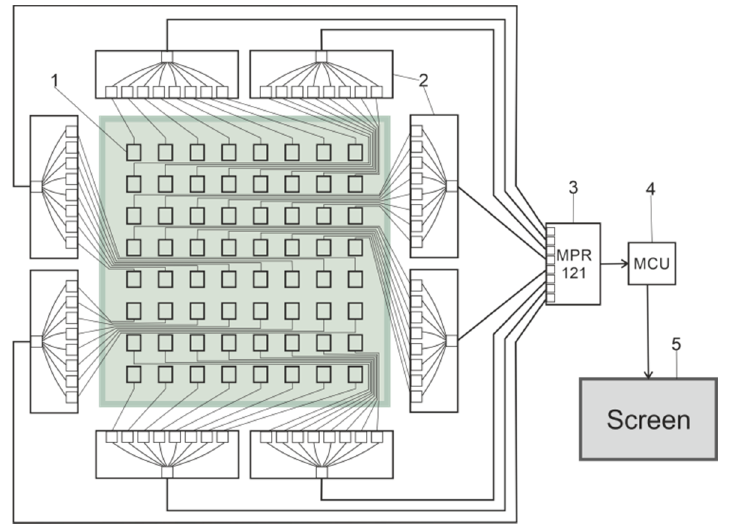
Figure 3. Scheme of the measuring system: 1—sensors, 2—multiplexers, 3—controller, 4—microcontroller, and 5—screen.